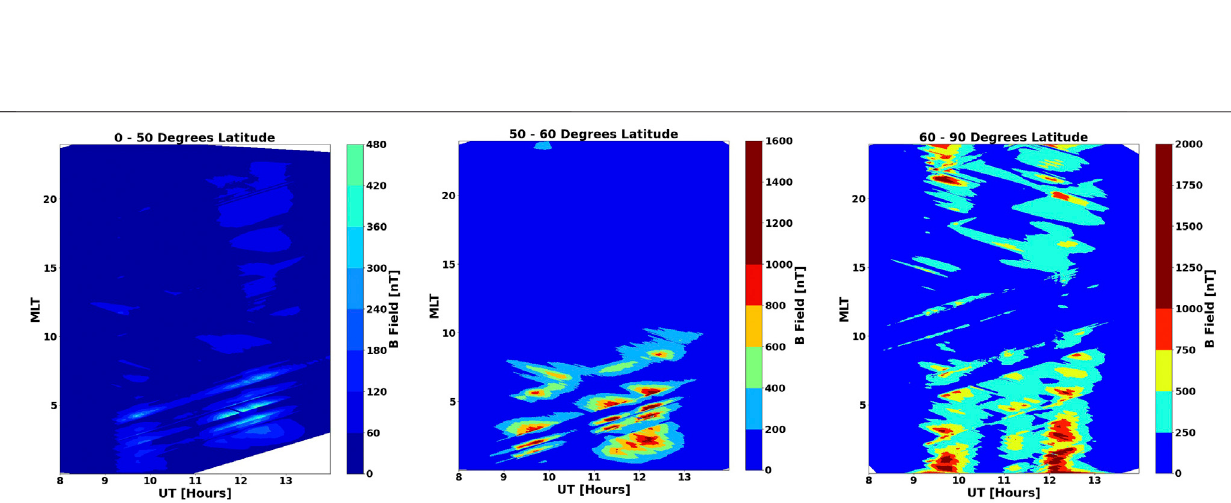
Frontiers in Astronomy and Space Sciences |